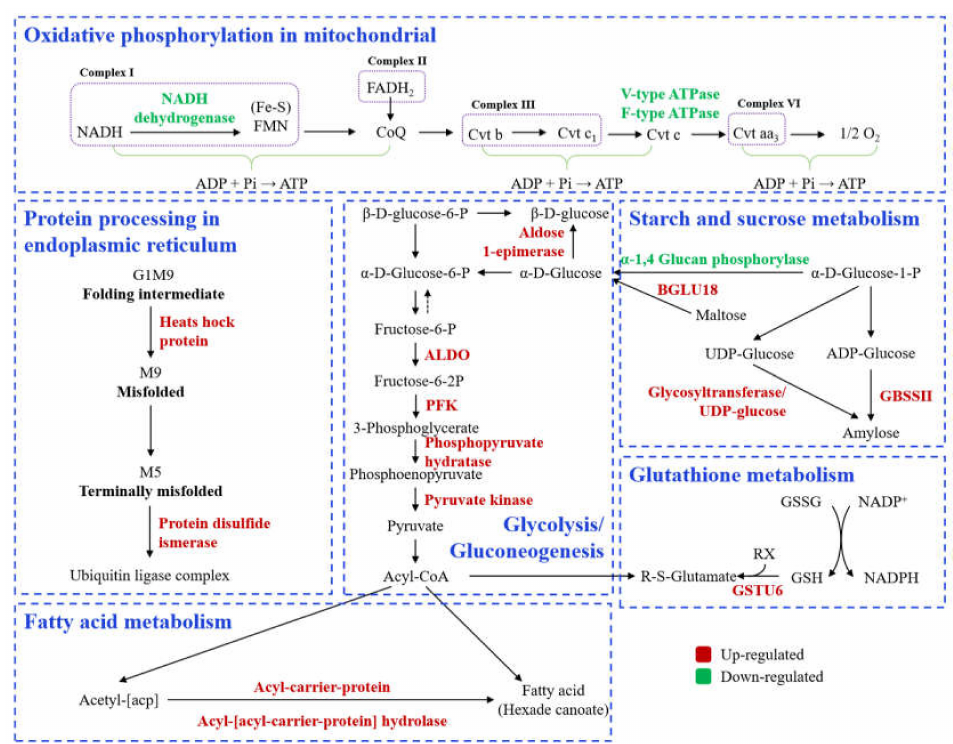
Figure 6. Storage drives alterations of metabolic pathways in Nanjing 9108 ( japonica rice).